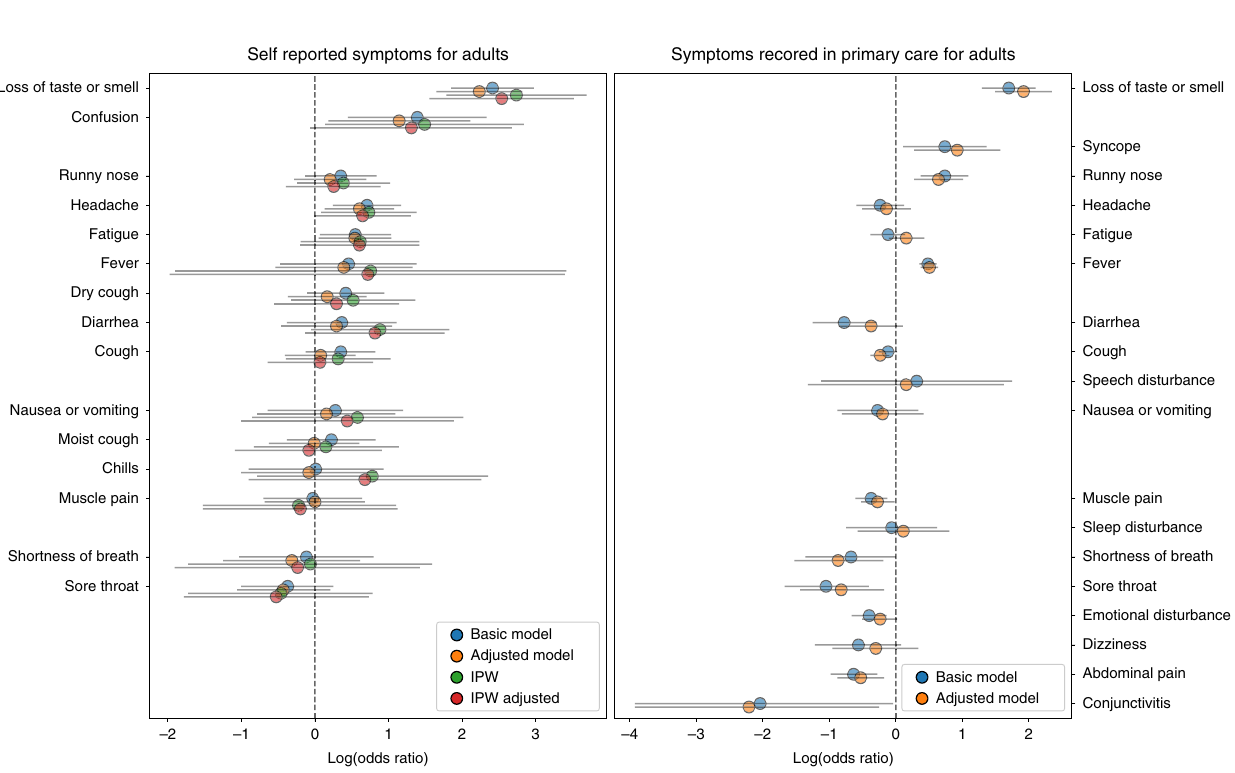
Fig. 2 Dynamics of symptoms in COVID-19 patients. Columns ( a – c ): each row represents the prevalence of a symptom in our cohort analyzed by time relative to diagnosis day from ( a ): Survey of self-reported symptoms and ( b ): Primary care visits in positive COVID19 cases (red) versus negative (blue) ( c ): Prevalence of symptoms in our cohort relative to time of recovery by surveys of self-reported symptoms (purple) and primary care visits (green). Each time point is calculated by taking a 1 week window (±3 days from day). Error bands represent 95% binomial proportion con fi dence intervals. Columns d , e : Kaplan – Meier curves from the time in which a symptom is self-reported ( d ) or recorded in the EHR ( e ) to a positive PCR result. The curves present the cumulative incidence of individuals who tested positive for COVID-19 and have a speci fi c symptom (orange) versus those who did not report this symptom (purple) in time. Hazard ratios (HR) adjusted for gender, age, prior conditions and time (number of days since study initiation) are indicated. Note the y - axis scale is different for each panel.